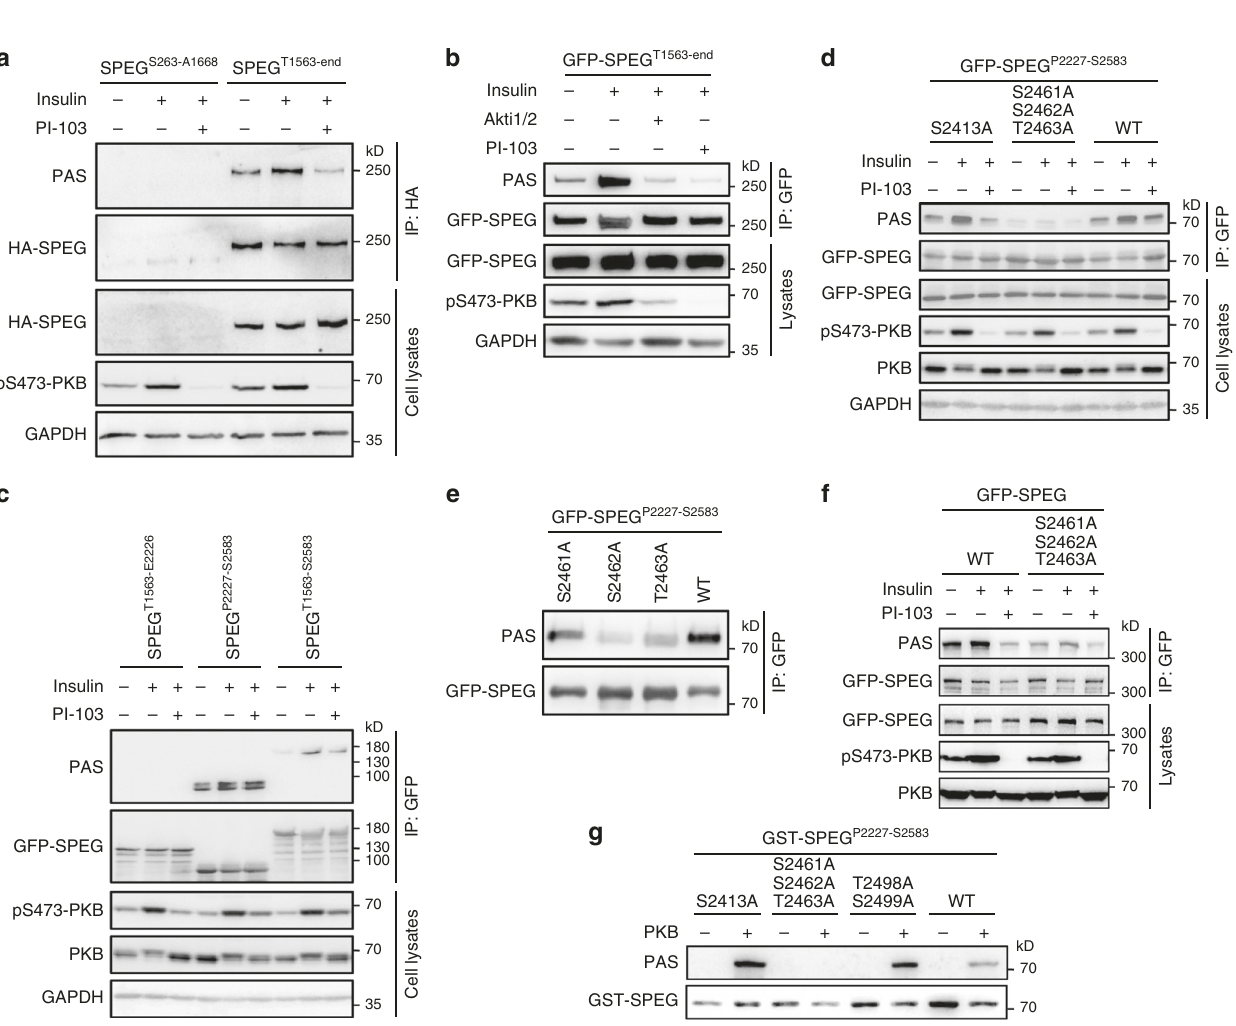
Fig. 3 Identi fi cation of PKB-mediated phosphorylation sites on SPEG. a – c SPEG fragments were expressed in HEK293 cells that were treated with indicated inhibitors and insulin. PAS-reactive phosphorylation of SPEG was detected on immunoprecipitated SPEG using the PAS antibody. d , e GFP- SPEG P2227-S2583 WT and mutant proteins were expressed in HEK293 cells. PAS-reactive phosphorylation of SPEG was detected on immunoprecipitated proteins using the PAS antibody. f GFP-SPEG WT and mutant proteins were expressed in HEK293 cells. PAS-reactive phosphorylation of SPEG was detected on immunoprecipitated proteins using the PAS antibody. g In vitro phosphorylation of GST-SPEG P2227-S2583 WT and mutant recombinant proteins by PKB. Source data are provided as a Source Data fi